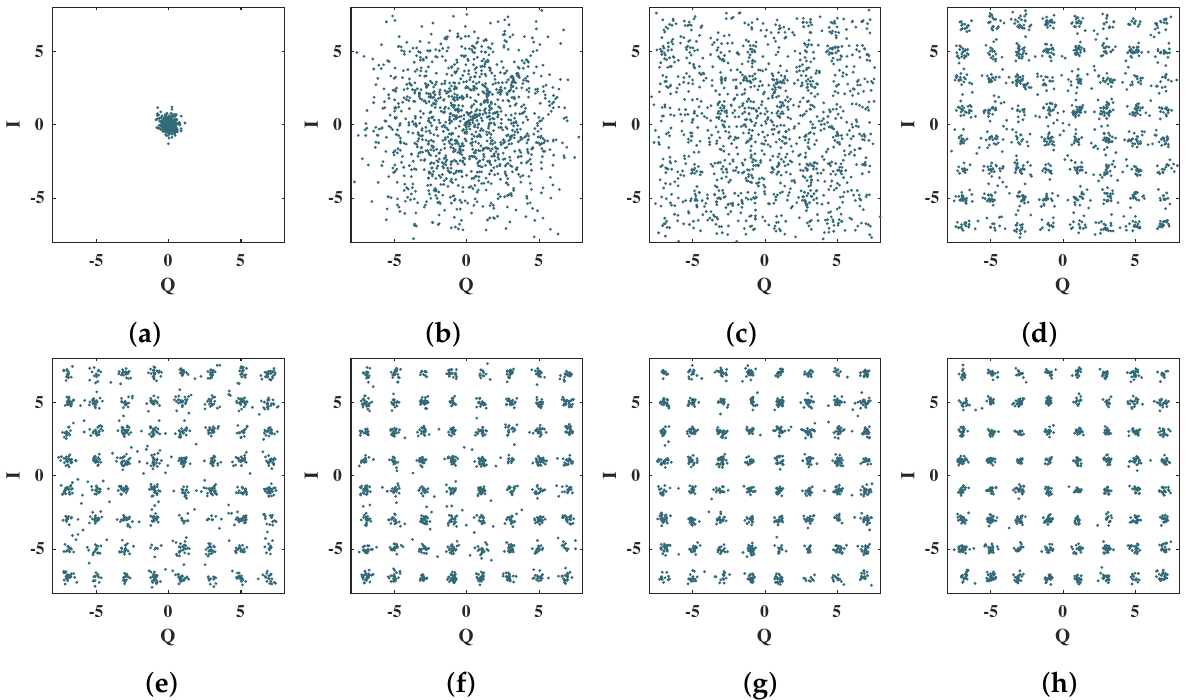
( g ) 6000 epochs, and ( h ) 7000 epochs. epochs, (d) 3000 epochs, (e) 4000 epochs, (f) 5000 epochs, (g) 6000 epochs, and (h) 7000 epochs.